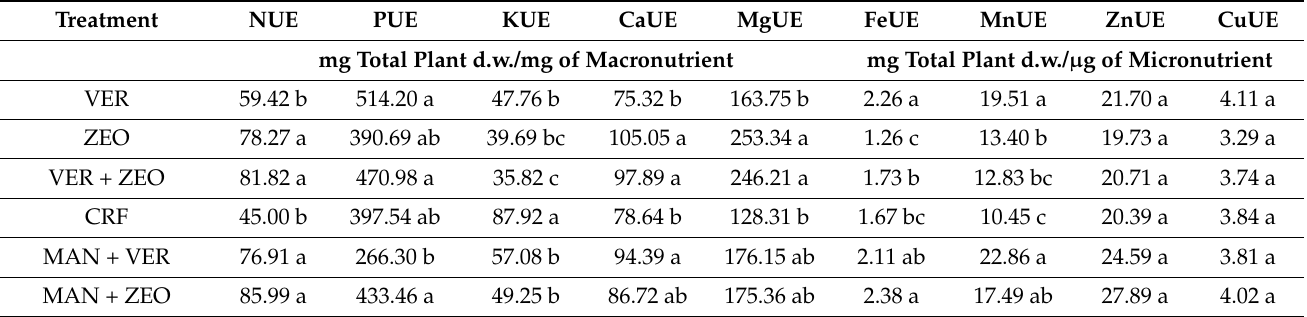
Table 6. Nutrient use efficiency of pepper plants among the